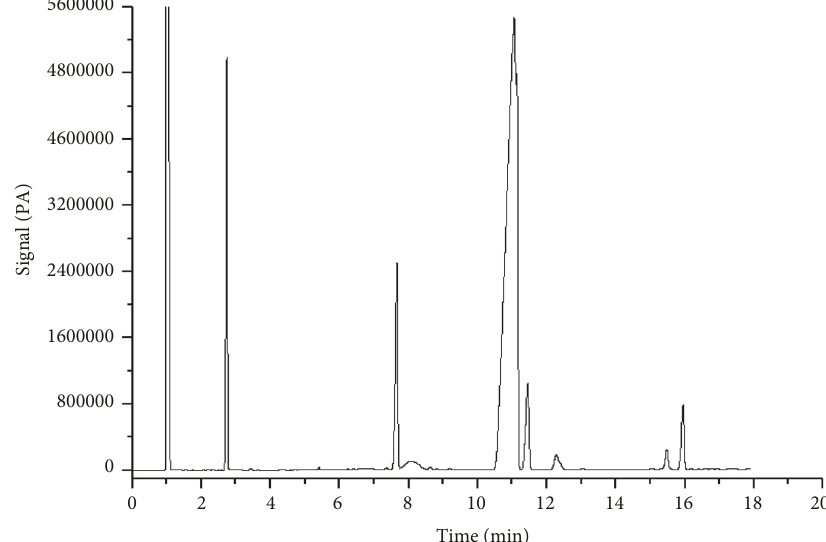
Figure 8: Chromatogram of shea butter methyl esters: (1) petroleum ether (solvent); (2) tetradecane (used as internal standard); (3) methyl palmitate (C16:0); (4) methyl linoleate (C18: 2(cis-9,12); (5) methyl oleate (C18:1(trans-9)); (6) methyl stearate (C18: 0) and (7) methyl arachidate (C20: